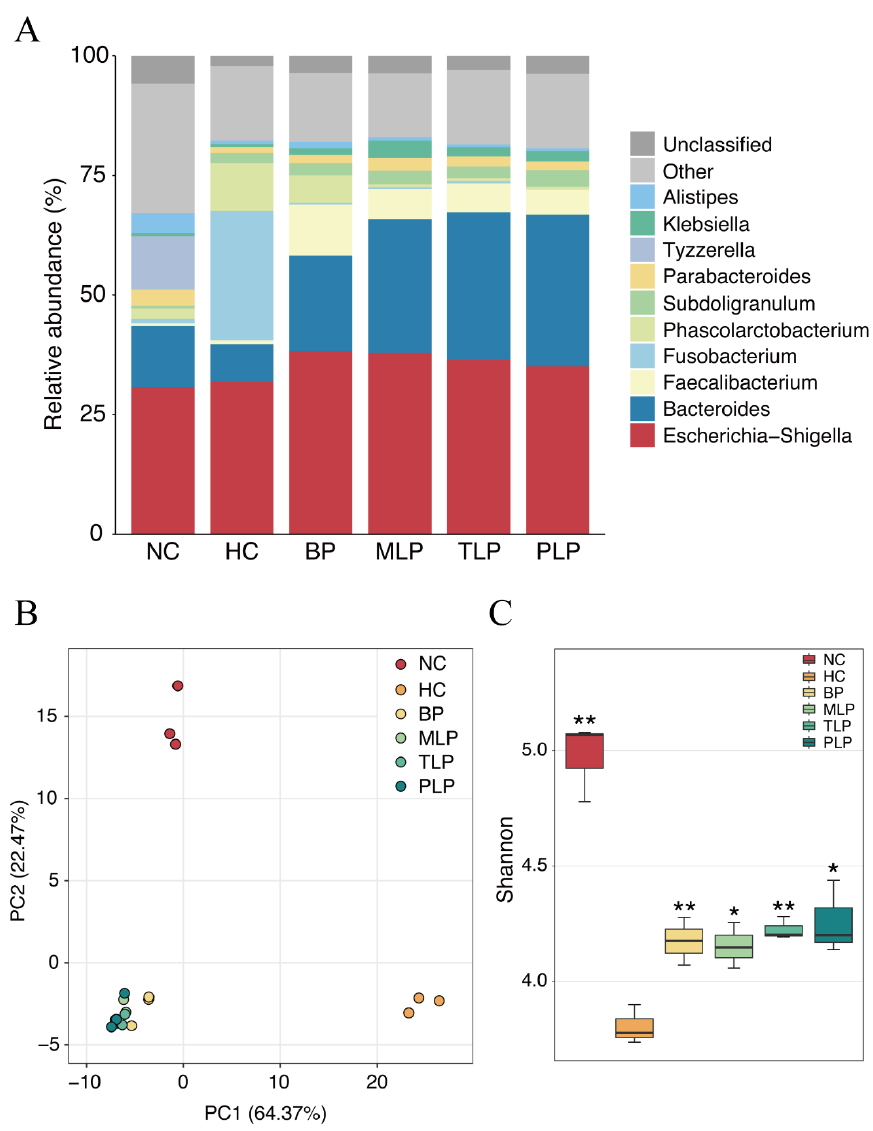
Figure 2. Microbial changes in different groups after 48 h of fermentation in vitro. ( A ) The relative abundance of the main taxa at the genus level. The beta diversity obtained using the ( B ) PCA analysis. ( C ) Shannon index demonstrated the alpha diversity. Differences from the HC group were assessed using Student’s t test and are denoted as follows: * p < 0.05, ** p < 0.01. NC: the feces of the healthy population were inoculated in FAM; HC: the feces of the hyperlipidemic people were inoculated in FAM; BP, MLP, TLP, PLP: the feces of the hyperlipidemic people were inoculated in FAMs with 0.5% of BP, MLP, TLP, and PLP. All experiments were repeated in triplicate (n = 3). A principal component analysis (PCA) was conducted to compare the operational taxonomic units (OTU) structure and community diversity of the gut microbiota in the five groups (Figure 2B). The results exhibited three statistical clusters among the NC and HC groups and the other four groups treated with BP and LPs, suggesting that hyper- lipidemia and further intervention by polysaccharides resulted in differences in the gut microbiota during fermentation. In the PCA model, the plot explained 64.37 and 22.4% of variables by PC1 and PC2, respectively, indicating that the profiles were credible.